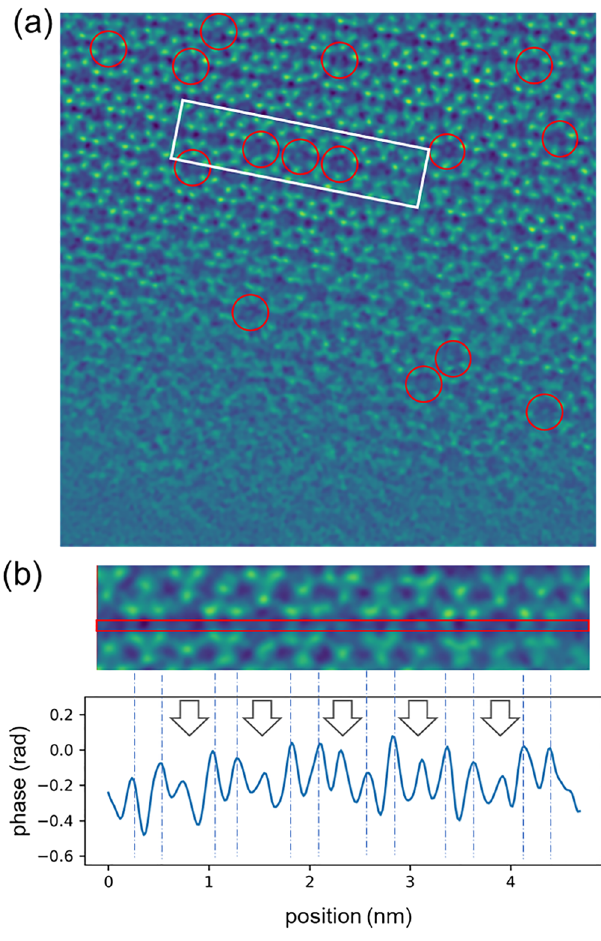
Figure 5. An image of Cu-containing CHA reconstructed with zero defocus. Red circles mark selected six- membered rings that contain Cu atoms with a high probability. ( b ) Line profile taken from the center of the white rectangle in ( a ). The arrows in ( b ) indicate the centers of six-membered rings, and the dotted lines mark the oxygen